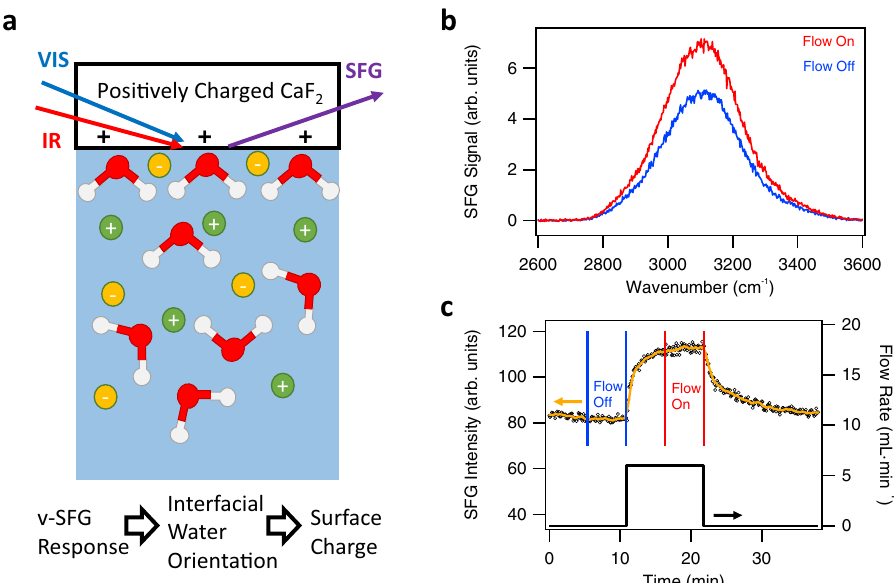
Fig. 1 Studying the CaF 2 -water interface by v-SFG. a Illustration of the measurement method. In vibrational sum frequency generation (v-SFG) spectroscopy, a visible (Vis) and infrared (IR) pulse overlap in space and time at the interface of interest, generating radiation at the sum of the frequencies (SFG). If an IR pulse is in resonance with the OH-stretch vibration of water molecules, the obtained v-SFG spectra provide information on the orientation and polarization of interfacial water molecules. The illustration shows water molecules for the fi rst few hydration layers as well as a schematic distribution of arbitrary ions (anions in yellow, cations in green). At the charged CaF 2 -water interface, the orientation and polarization of the interfacial water molecules is determined by the surface charge. Thus, the v-SFG signal can be used as an indirect measure for the surface charge. b v-SFG spectra in arbitrary units (arb. units) in the OH-stretch region of the CaF 2 -water interface at pH 3 (1 mM HCl and 1 mM NaCl) under fl ow-off conditions (blue) and fl ow-on conditions (red). c Time trace of integrated SFG spectra (black circles) at the CaF 2 -aqueous solution interface at pH 3 (1 mM HCl and 1 mM NaCl) with one fl ow on-off cycle (black curve). Each circle represents one spectrum, integrated between 2650 and 3600 cm − 1 . The solid orange line is a ten-point moving average to guide the eye. The vertical blue and red lines highlight the steady-state regimes for fl ow-off and fl ow-on conditions. As the intensities are hardly changing over time, a steady-state can be